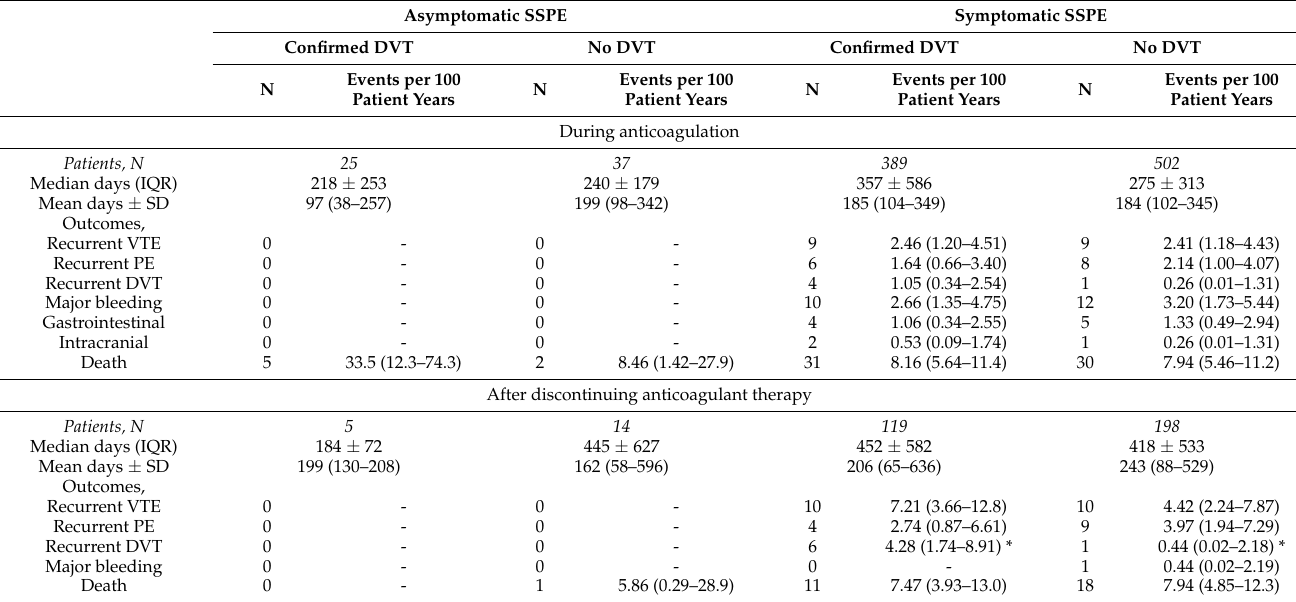
Table 5. Clinical outcomes during the course of anticoagulant therapy and after its discontinua- tion, according to the existence of concomitant lower-limb deep vein thrombosis. Patients with no compression ultrasound are not